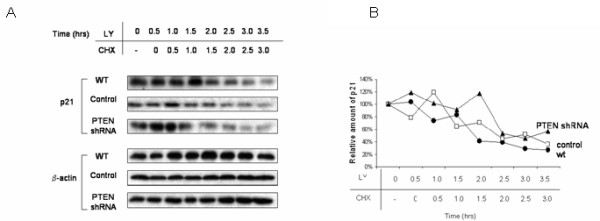
Stabilization of p21 in PTEN-knockdown cells iseabrogated by PI3K inhibition with LY-294,002. a. Wild type ACHN cells as well as those stably transfected with PTEN-shRNA or empty vector were incubated with LY-294,002 (10 μM) for the times indicated in the presence of cycloheximide (CHX; 20 μg/ml) for the times indicated, and cell lysate was immunoblotted with antibodies against p21 or β-actin. b. A graphical representation of the data using densitometry of p21 and actin bands is reported as ratio of p21/β-actin and is normalized to the "0 CHX control" for each lane. A representative experiment is shown of three done.